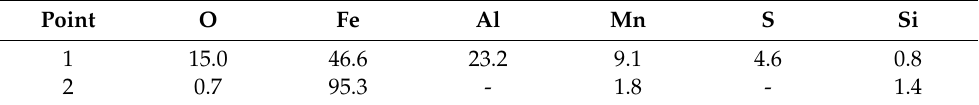
Table 6. Mn-Si-HT steel, results from EDS analysis of the corrosion spot in